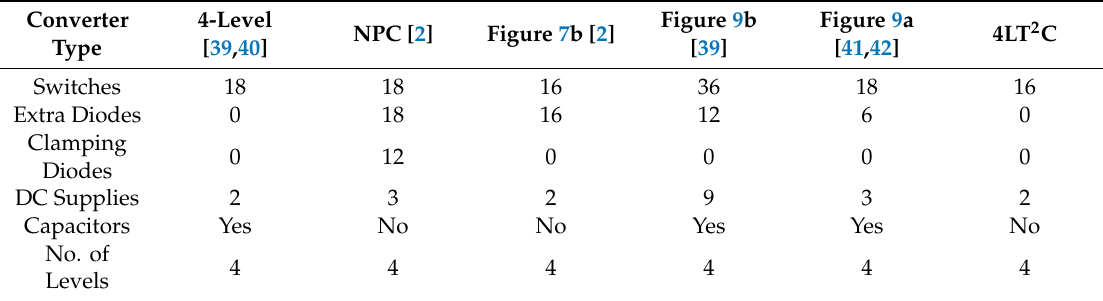
Table 7. Comparison between the proposed 4LT 2 C and other topologies.